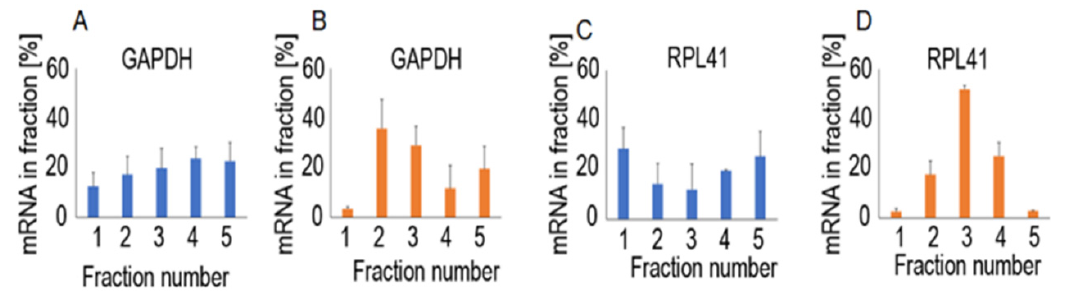
Figure 4. Distribution of mRNA for the GAPDH ( A , B ) and RPL41 ( C , D ) genes in sucrose gradient fractions from HCT116 ( A , C ) and Me45 ( B , D ) cells transfected with psiCHECK-2 containing control reporter genes. Fractions number 1—free RNA, 2—small subunit, 3—monosome, 4—light polysome, 5—heavy polysome.